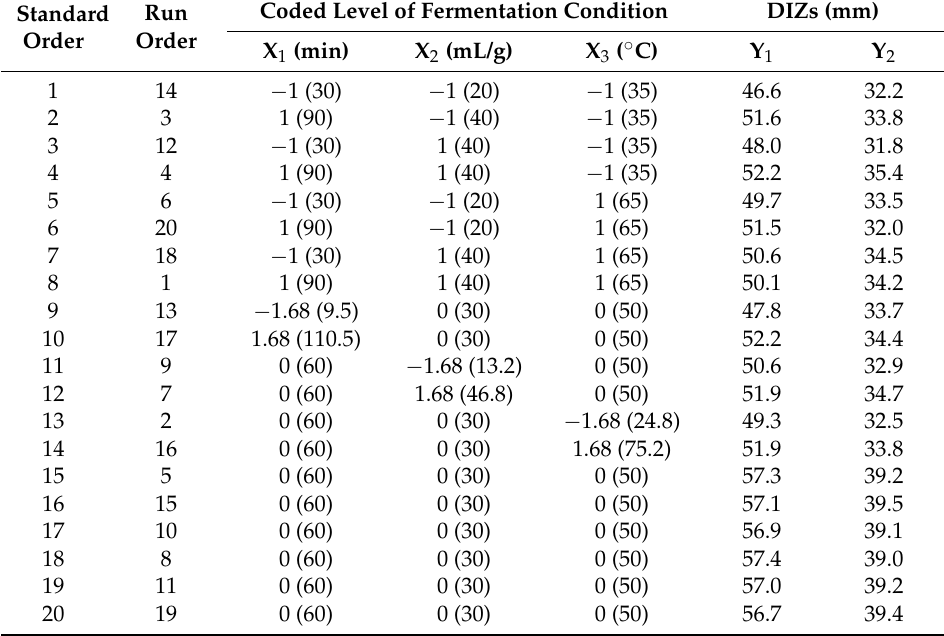
Table 1. A central composite design for independent variables and their responses.